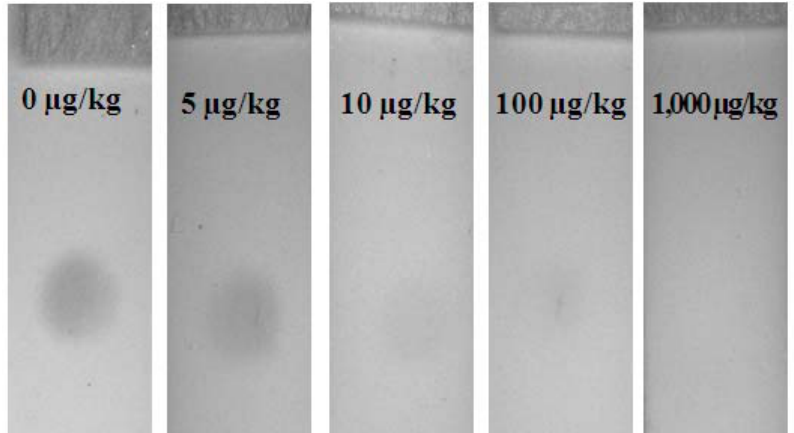
Figure 4. Detection limit of AFB1 with the one-dot